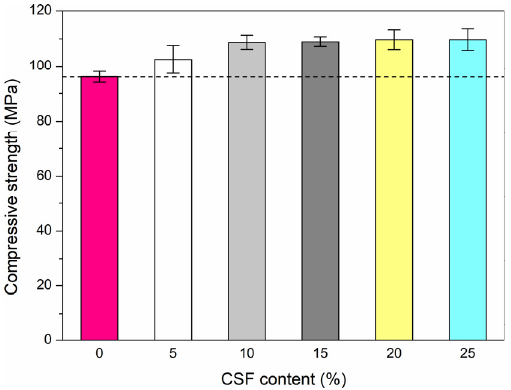
Figure 2. Differences in compressive strength with CSF substitution.